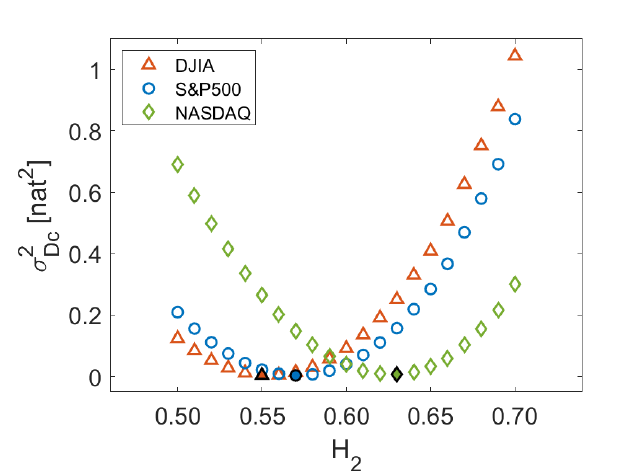
Figure 4: Plot of the quantity σ 2 defined by Eq. (6) for the relative cluster en- D C tropy curves plotted in Fig. 3 vs. the Hurst exponent H of the model distribution 2 Q ( τ , n ) . The quantity σ 2 is the variance of D with respect to 0 (the null hypothe- j C D C < 20. Each point is evaluated sis for P = Q ) over the cluster lifetime interval 1 < τ j by using the definition given in Eq. (6) for each market and for each f Bm with as- signed Hurst exponent H . The Hurst exponent H of the model distribution Q ( τ , n ) j 2 2 ranges between 0.50 and 0.70 with step 0.01. The minimum value of the variance is = 0.55 (DJIA), H = 0.57 (S&P500) and H = 0.63 obtained for H 1 1 1